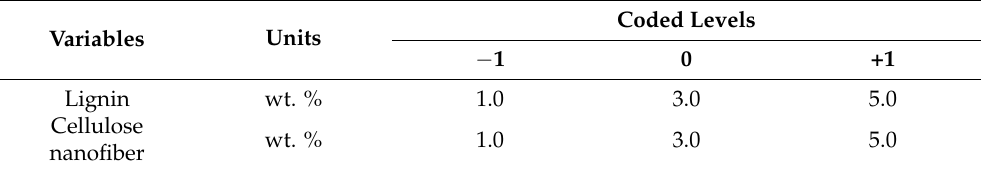
Table 7. Experimental variables and their coded levels of variables levels for